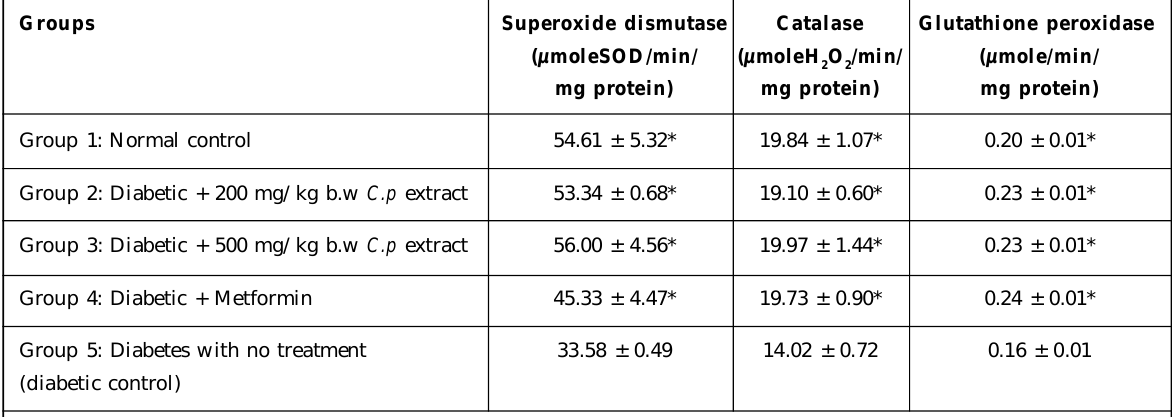
Table 3: The Mean ± SEM of the antioxidant enzymes activity of the Normal control, those treated with C.p extract, metformin, and diabetic control (untreated) of the Wistar rats after 21 days Groups